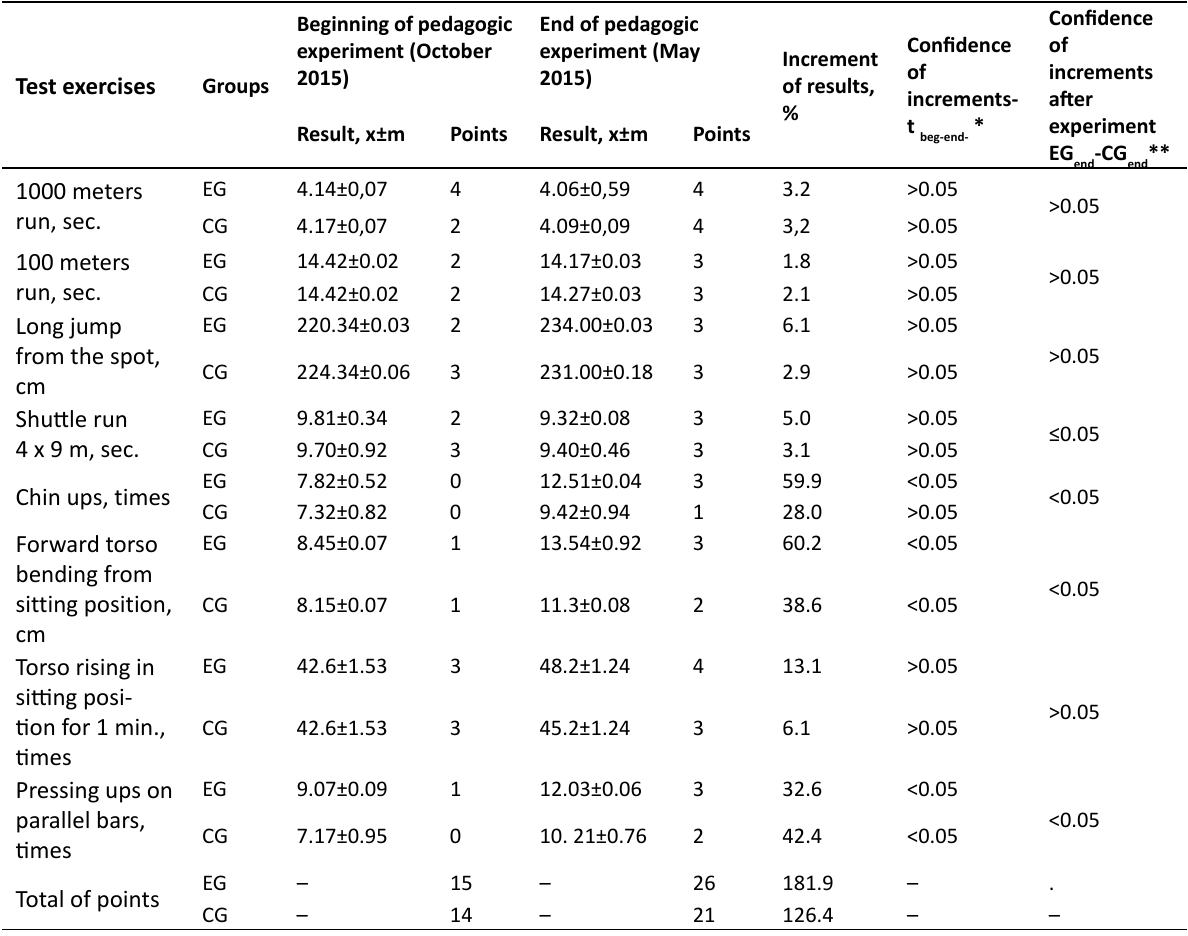
Table 1. Results of students’ fulfillment of tests for physical fitness